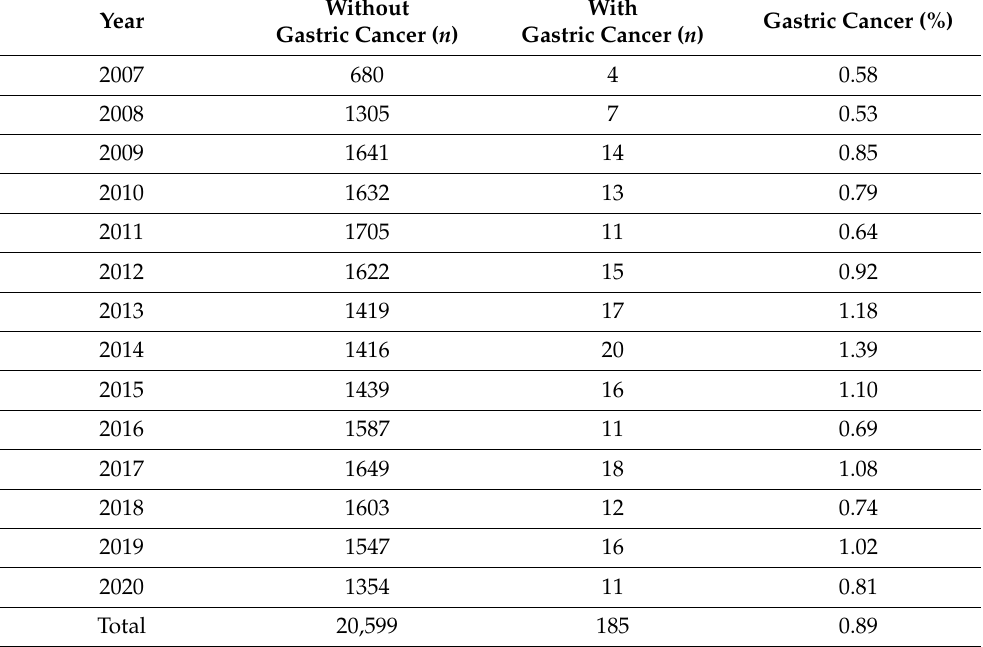
Table 1. Sample distribution by study